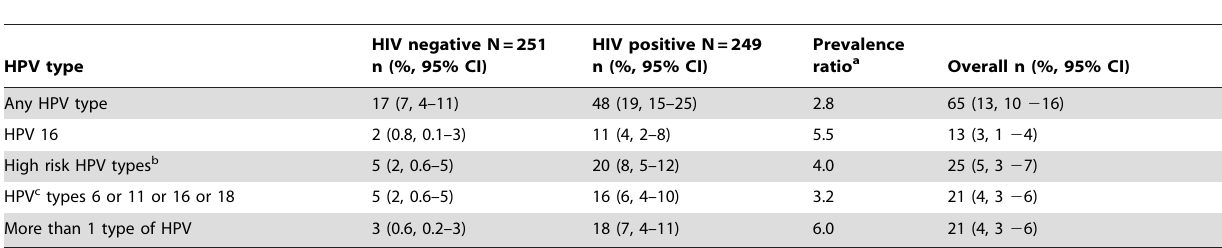
Table 1. Prevalence of oral HPV types, by HIV status, in 500 men who have sex with men.